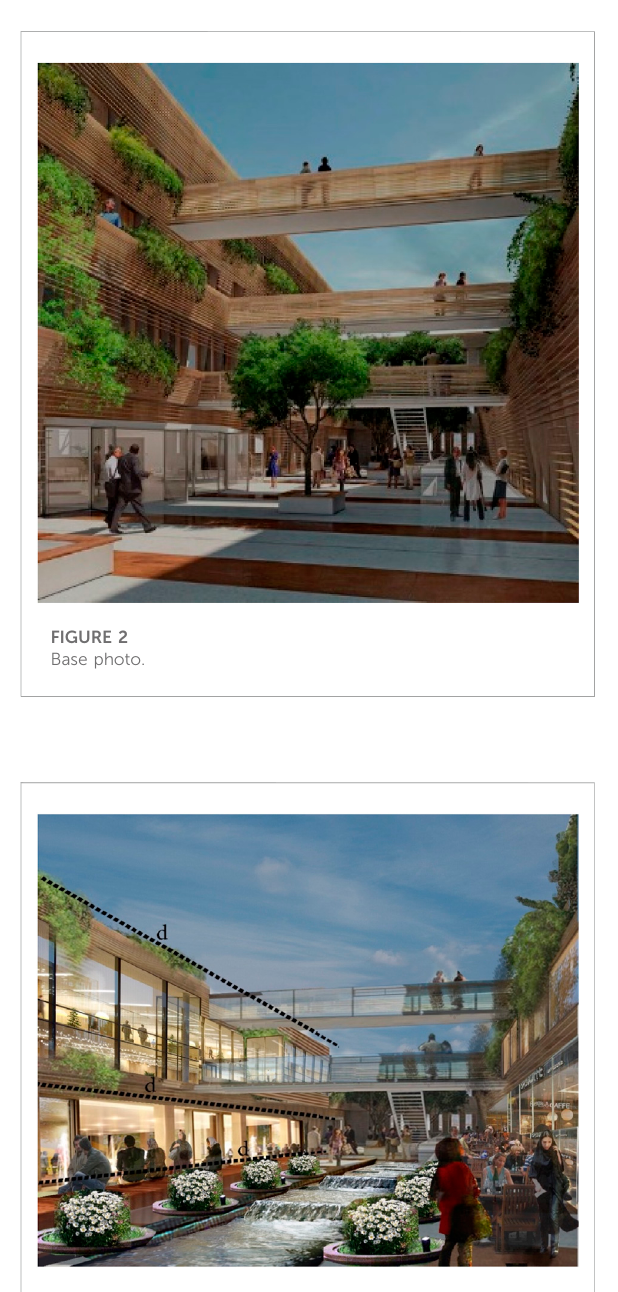
used to check the consensus calculated by SPSS software. Seven factors (namely shape, material, height, facade orientation, solid/void patterns, water, and plants) with scores close to one [i.e., 0.9 ( very strong consensus ) and 0.7